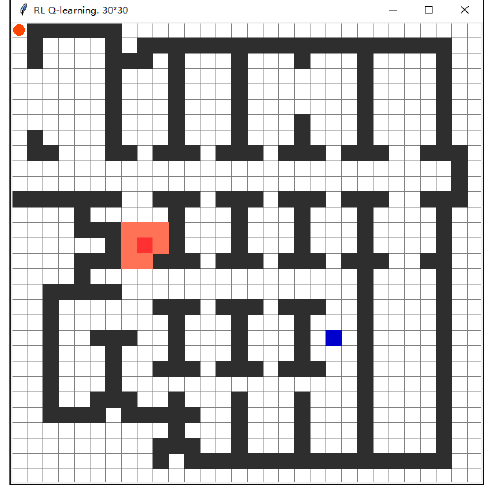
Figure 10. Fire simulation environment.